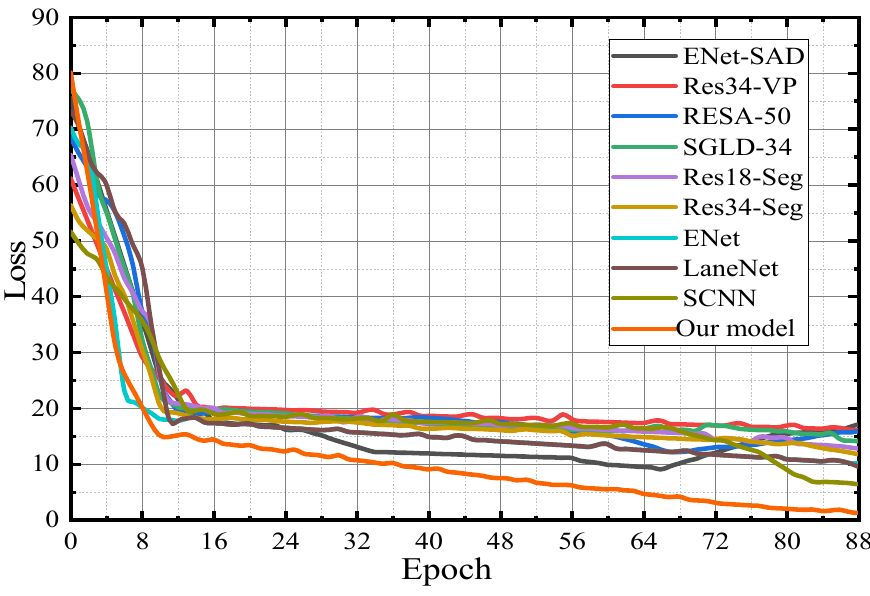
Figure 13. Model verification—loss function graph.